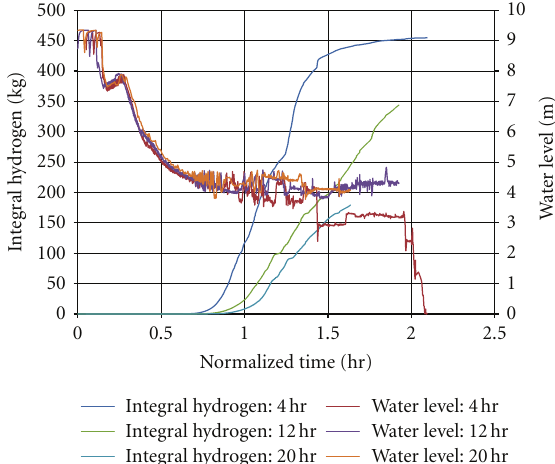
Figure 20: Integral hydrogen production and water levels for scenarios with depressurization and termination of emergency water injection at 4.2, 11.8, and 19.6 hours after reactor scram (CRD flows maintained).